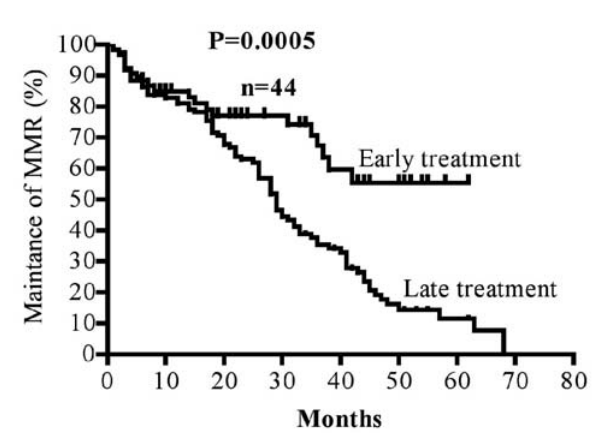
Figure 2 - Kaplan-Meier estimates of major molecular remission (MMR) according to the time interval elapsed between diagnosis and the initiation of imatinib therapy